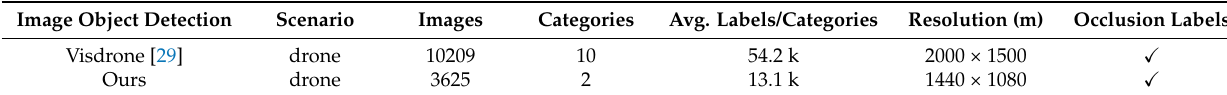
Table 4. Comparison of Visdrone and our